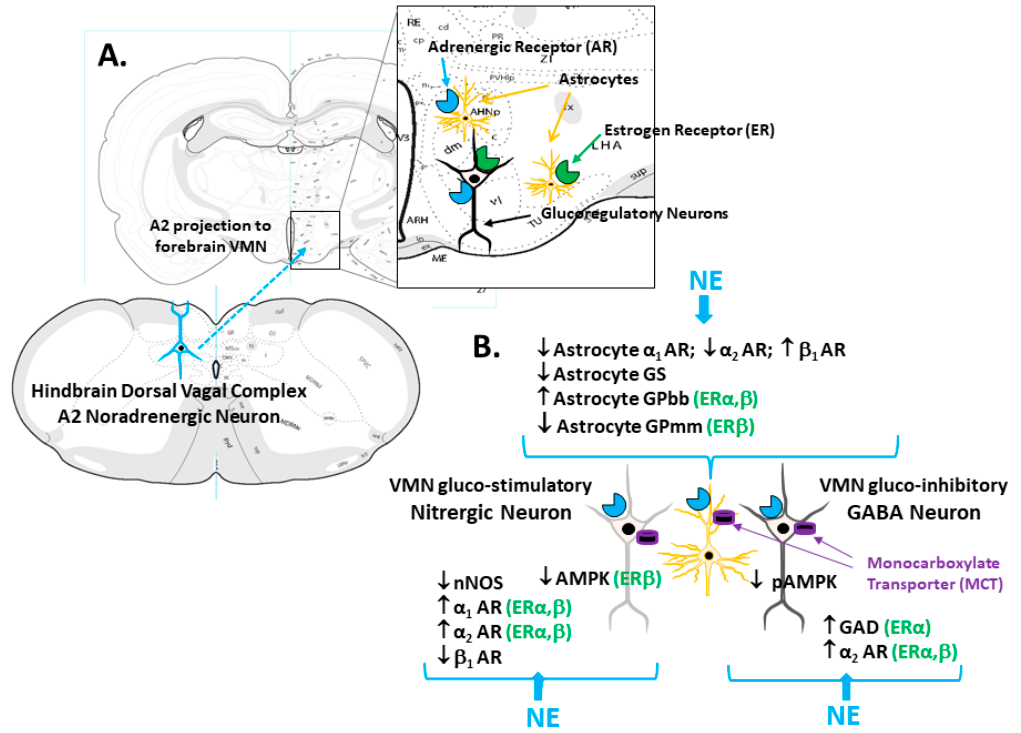
Figure 1. Model for Estrogen Receptor (ER) Modulation of Hindbrain A2 Noradrenergic Control of Ventromedial Hypothalamic Nucleus (VMN) Glucoregulatory Transmission. The enlarged rectangle in Panel A depicts ER and adrenergic receptor (AR) expression by VMN glucoregulatory neurons and astrocytes. Panel B illustrates ER-alpha (ER α ) and / or ER-beta (ER β )-dependent NE control of VMN astrocyte glycogen metabolic enzyme protein (glycogen phosphorylase-brain (GPbb) and -muscle (GPmm) type) expression. The same panel shows differential ER modulation of noradrenergic influence on gluco-stimulatory nitrergic ( α 1 AR; α 2 AR; AMPK) versus gluco-inhibitory GABAergic (glutamate decarboxylase (GAD); α 2 AR) protein profiles. NE control of glucoregulatory signaling likely involves direct action on nitrergic and GABA neurons as well as regulation of astrocyte provision of glycogen ‐ derived substrate fuel, e.g., lactate, by monocarboxylate transporter (MCT) function.